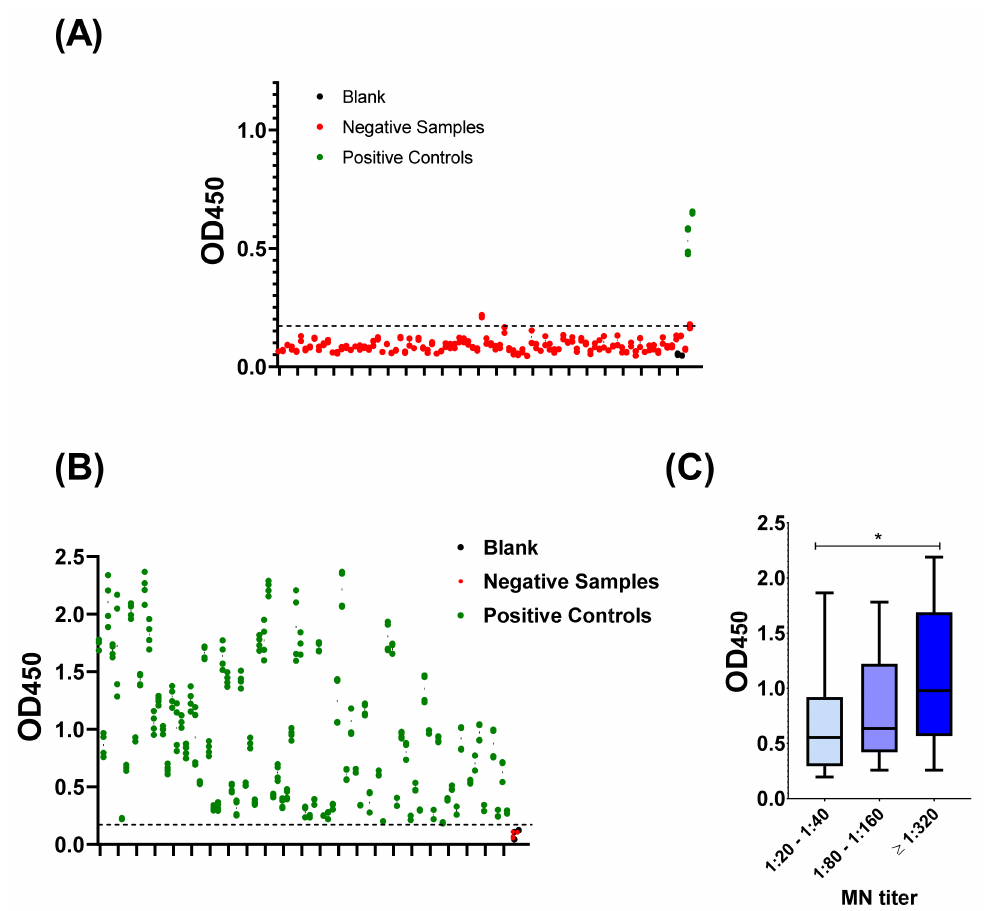
Figure 2. Validation of the developed COVID-19 NP IgG ELISA. ( A ) The cut-off value of the assay. Negative samples (red) and positive control (green) based on micro-neutralization assay in addition to blank (black) were utilized. The actual OD 450 values for each sample are shown. Dashed lines represent the cut-off value 0.17, which was calculated as mean + (3 × standard deviation). ( B ) Positive samples (green) and negative control (green) based on micro-neutralization assay in addition to blank (black) were utilized. OD 450 values for all positive samples were above the cut-off value. ( C ) correlation between ELISA results and MN titer. One-way ANOVA was applied. * indicates p value <